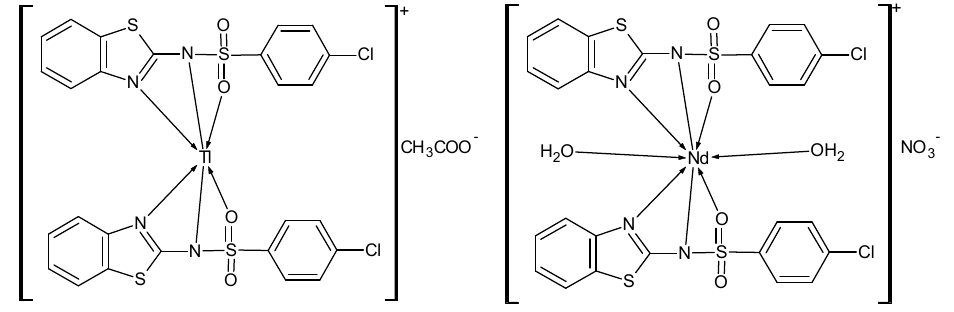
Figure 6. Proposed structure of the complexes.